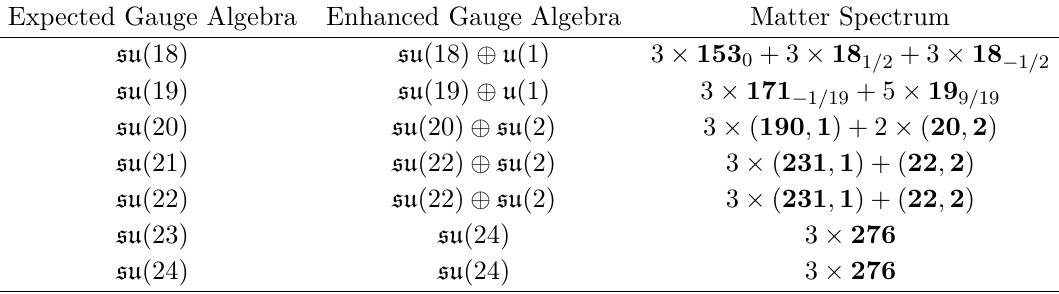
Table 1 . Enhanced gauge algebras observed when attempting to tune various expected gauge algebras along a divisor of class H on P 2 , along with the observed matter